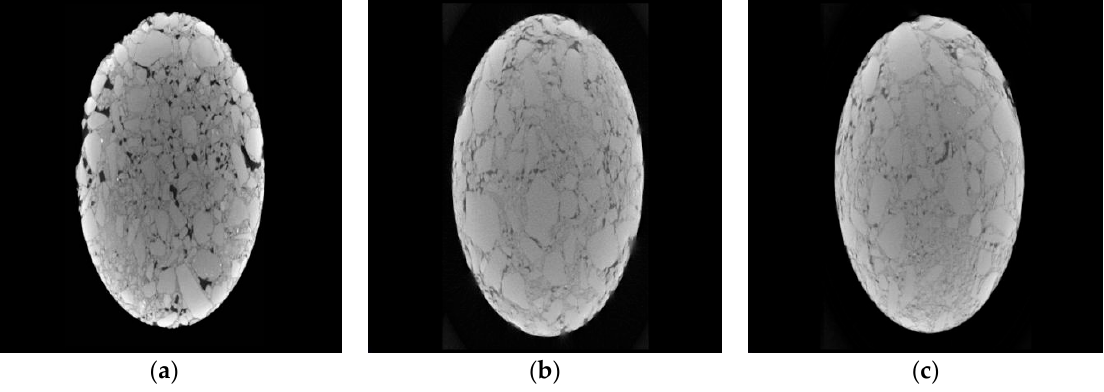
Figure 22. Three-dimensional CT scanning images of R 0 C 0 ( a ), R 1 C 0 ( b ) and R 1 C 0.09 ( c )